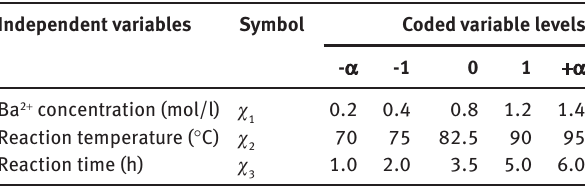
Table 1: Variables and their corresponding levels in the experimental